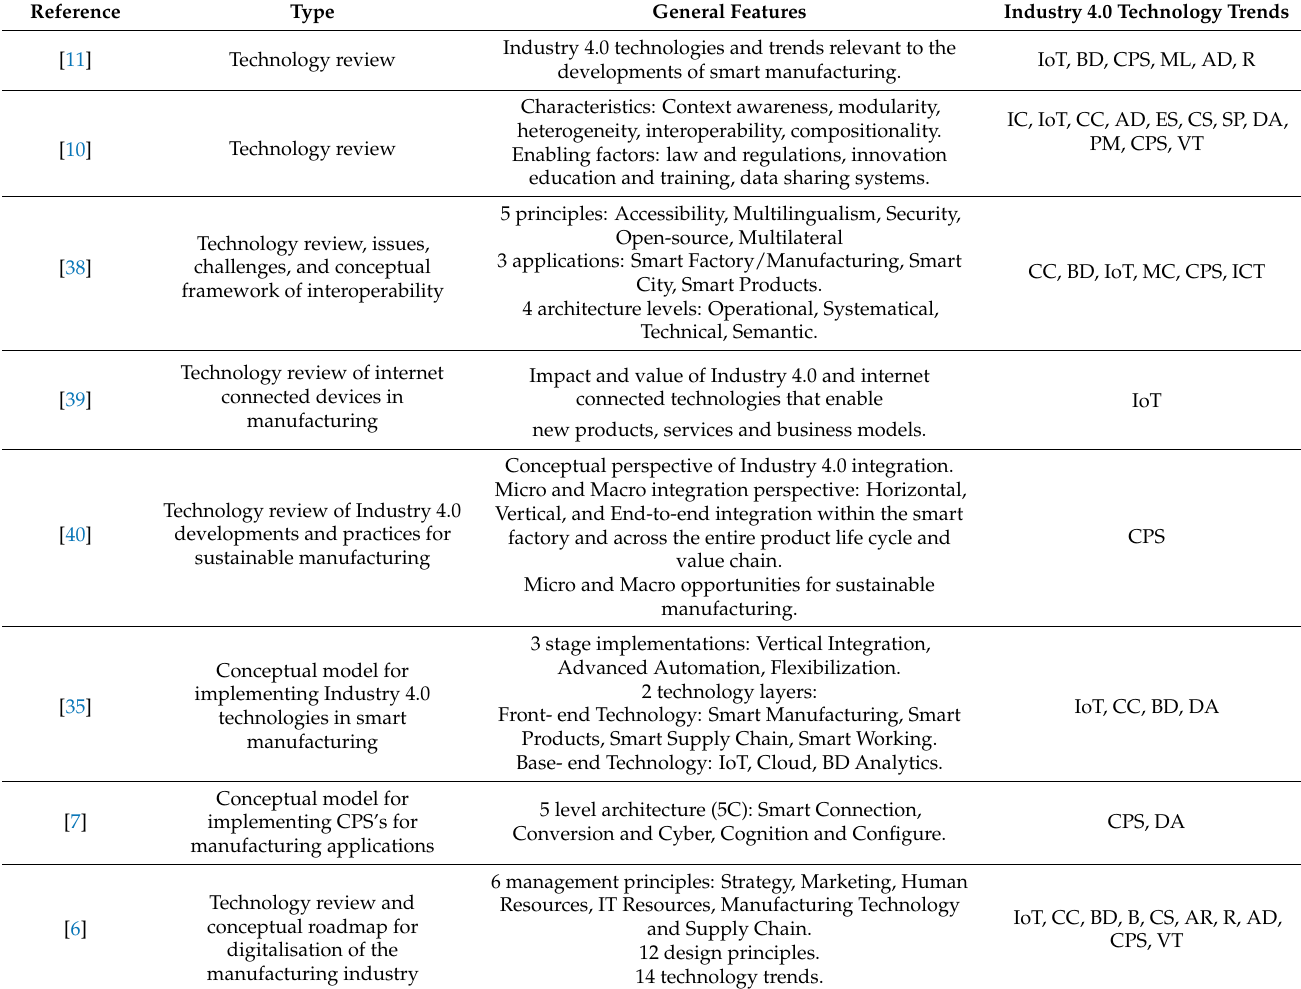
Table A1. A summary of key academic and industrial documents in the context of smart manufacturing and Industry 4.0.